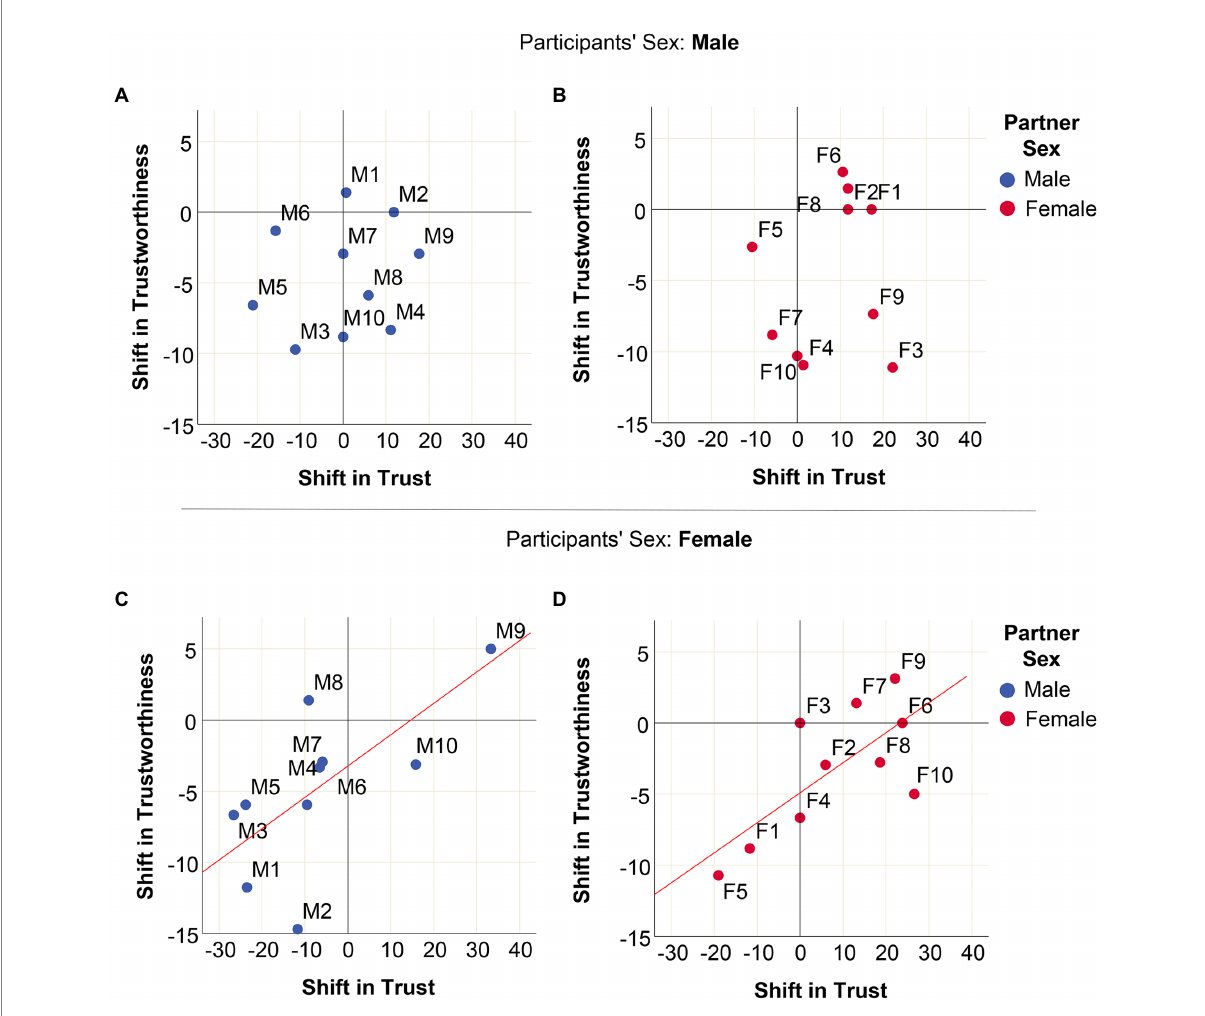
FIGURE 5 Associations between trust and trustworthiness as elicited by 10 male and 10 female videos. Major axis regression analysis of the association between shifts in trust ( x -axis) and shifts in trustworthiness ( y -axis) elicited by 20 videos (males: M1–M10, 10 females: F1–F10). (A) Effect of male videos on male subjects: R 2 = 0.038, Beta = 0.066, p = 0.306; (B) effect of female videos on male subjects: R 2 = 0.028, Beta = − 0.115, p = 0.330; (C) effect of male videos on female subjects: R 2 = 0.449, Beta = 0.217, p = 0.014; (D) effect of female videos on female subjects: R 2 = 0.499, Beta = 0.214, p = 0.013. Major axis regression lines are presented only for significant